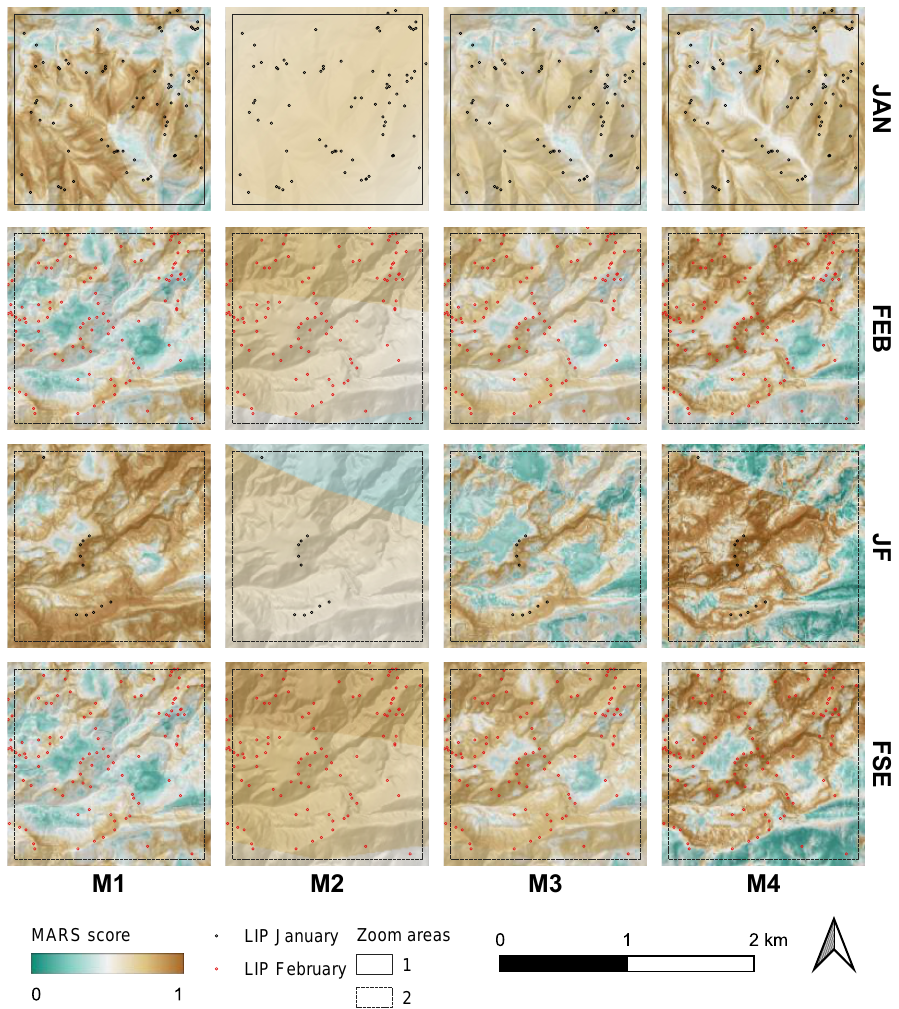
Figure 12. Examples of the landslide susceptibility maps extracted from the zoom areas 1 (dataset JAN) and 2 (datasets FEB, JF and FSE).